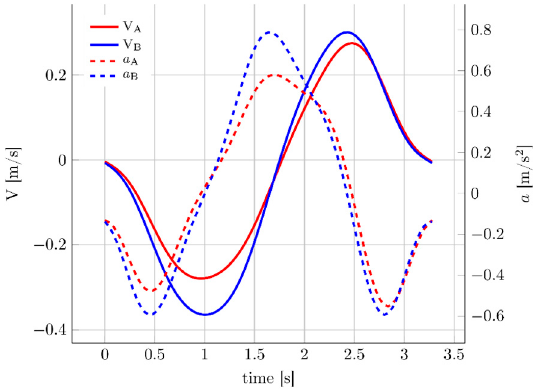
Figure 5. Characteristic records of horizontal particle velocities recorded by ADV A (left) and ADV B (right).